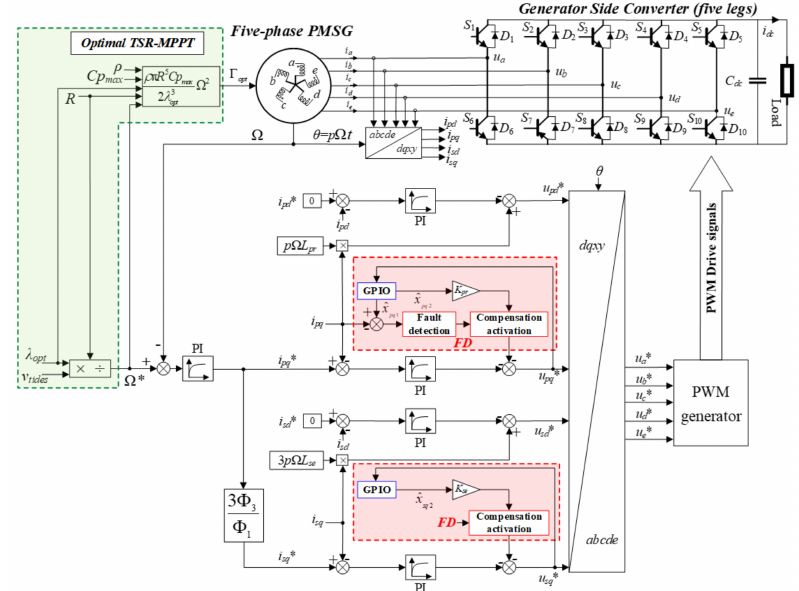
Figure 6. Active fault-tolerant control scheme of a five-phase PMSG based